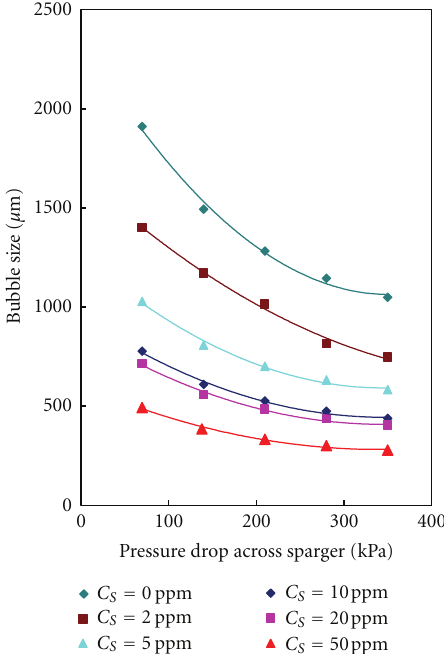
Figure 4: E ff ect of sparger pressure drop on the predicted size of bubbles generated by the dual-fluid transonic sparger ( U G = 0.008 ms − 1 , W L /W G =